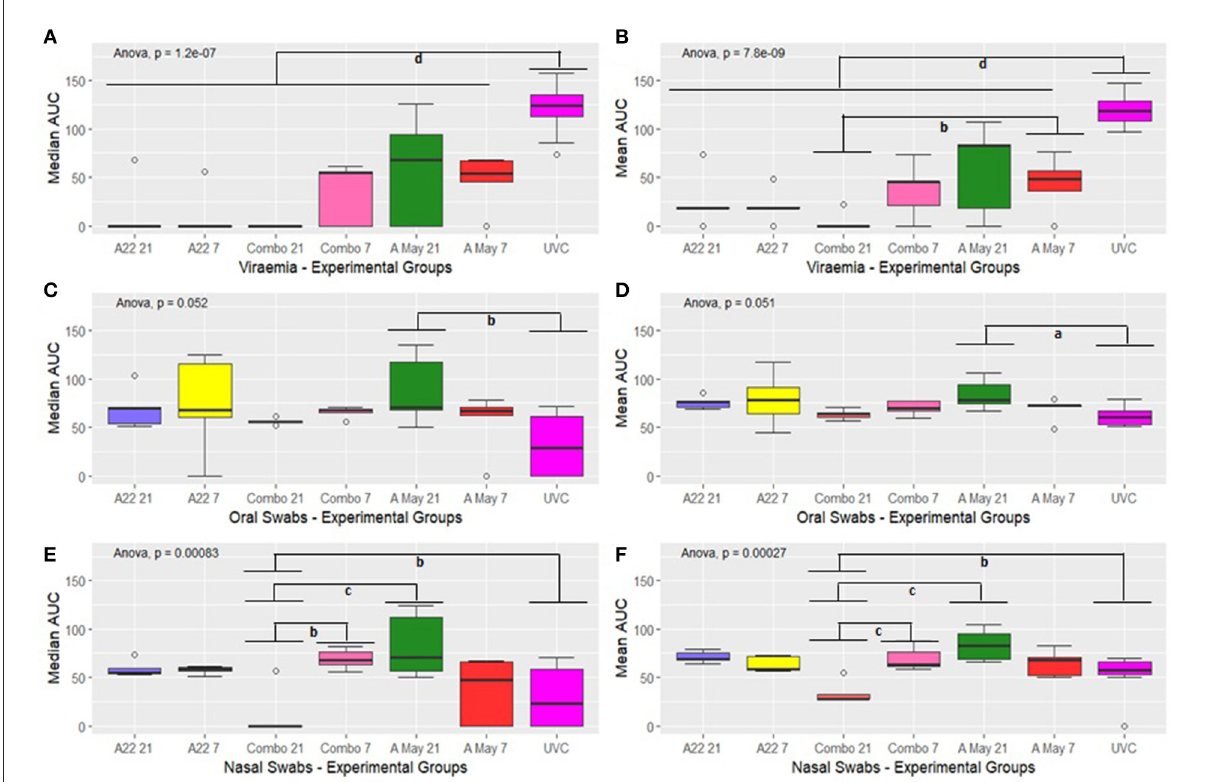
FIGURE5 Box plot showing median and mean AUC of virus load in the blood (A,B) , oral fluids (C,D) and nasal secretions (E,F) . The boxplots show the interquartile range (median represented as the thick horizontal line within the box, and the first and third quartile of the data) and the minimum and maximum values for each group connected to the boxes with the vertical line. Groups with subscripts differ significantly. a = p < 0.1; b = p < 0.05; c = p < 0.01 and d = p <